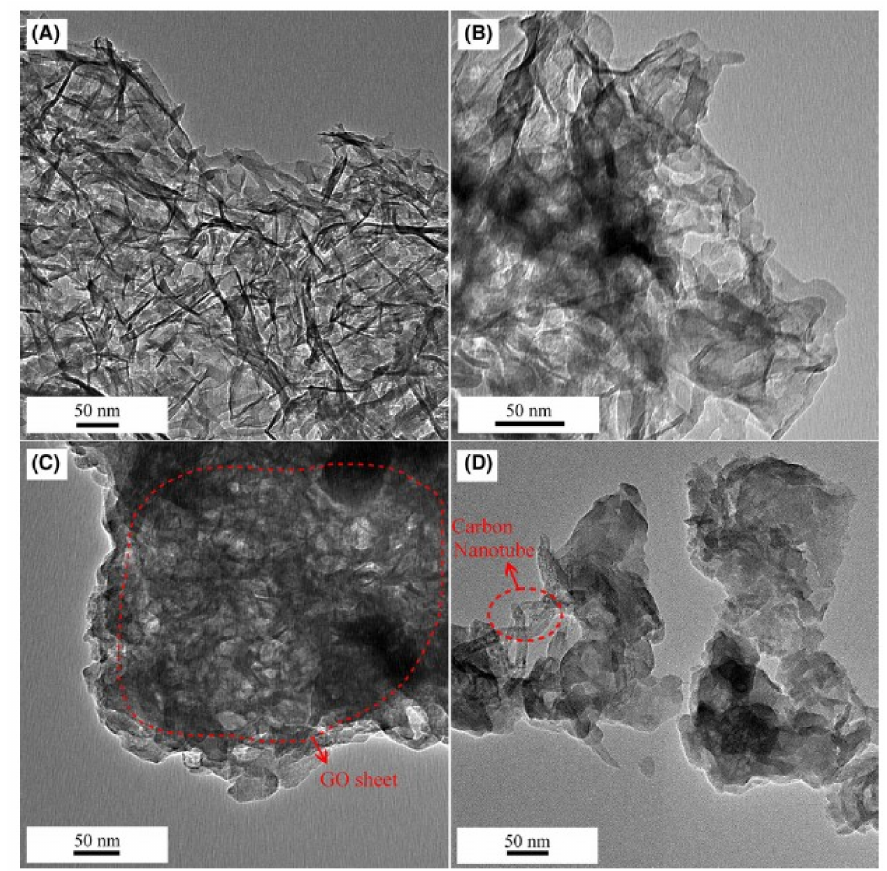
Figure 15. TEM images of the C–S–H incorporate di ff erent nanomaterials: ( A ) 2% nano-TiO 2 , ( B ) 2% nano-SiO 2 , ( C ) 0.5% GO, ( D ) 0.5% CNT. Reproduced from [129], with permission from John Wiley and Sons,